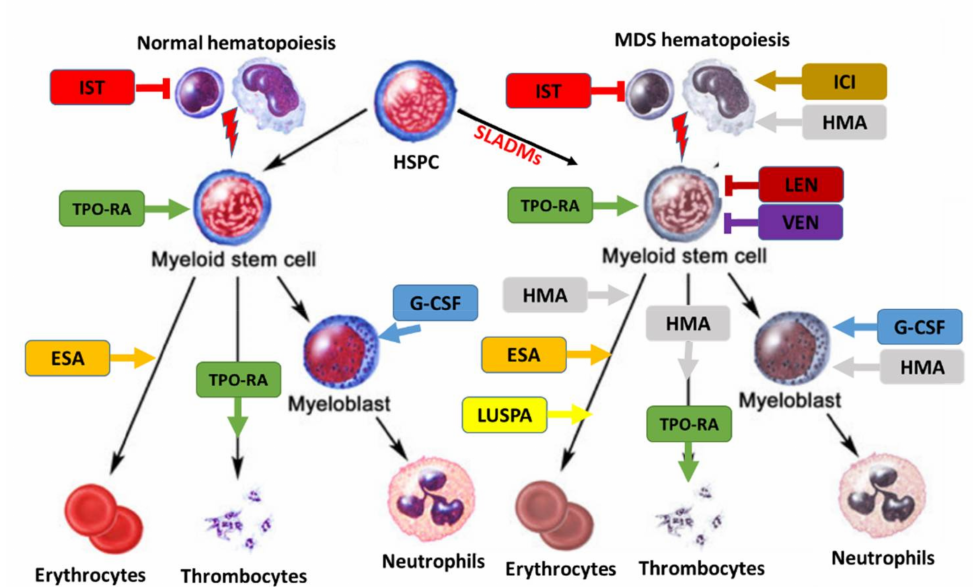
Figure 4. Treatment landscape in MDS. Treatment can affect normal ( left ) and clonal hematopoiesis ( right ). SLADMs: somatic leukemia-associated driver mutations; ESA, erythropoietin stimulating agent; ICI, immune checkpoint inhibitors; G-CSF, granulocyte colony stimulating factor; HMA, hy- pomethylating agents; IST, immune suppressive treatment (CyA/ATG); LEN, lenalidomide; LUSPA, luspatercept; TPO-RA: thrombopoietin receptor agonists; VEN, venetoclax. Adapted from